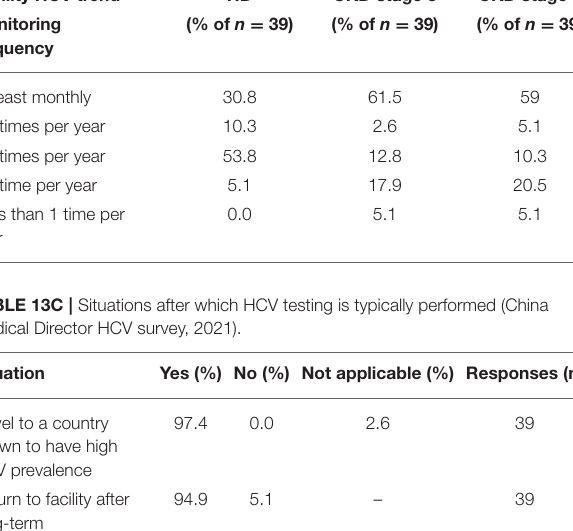
TABLE 13B | Frequency of monitoring facility HCV trends, by ESKD stage (China Medical Director HCV survey, 2021). Facility HCV trend